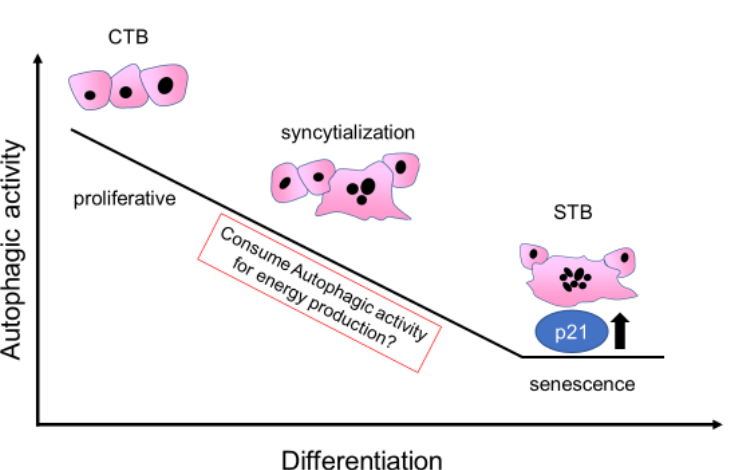
Figure 6. The model of autophagic activity during syncytialization Autophagic activity was sustained in CTB. The activity in STB was lower than that in CTB, suggesting that its activity was gradually decreased during syncytialization. The correct terminally syncytialized cells expressed p21, a senescent marker, as well as hCG and CYP11A1. A lysomal inhibitor, BAF A1, and a lysosomotropic agent, LLOMe, induced the failure of syncytialization, which were characterized by no increase in p21, CYP11A1, and hCG, in BeWo cells. Collectively, autophagic activity might be required for the initiation of syncytialization.